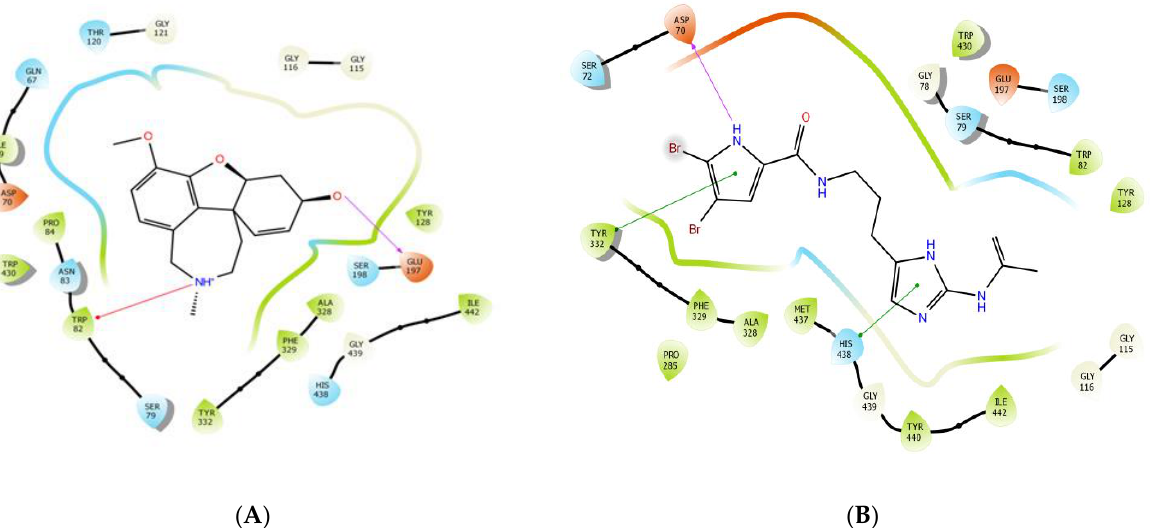
Figure 5. Prediction binding mode of galantamine ( A ) and N-acetyl-17-oroidine ( B ) into the entire BChE-active pocket. The same color code used in Figure 3 was applied. Table 3. Molecular docking scores and interactions of N-acetyl-17-oroidine with AChE- and BChE- active site.